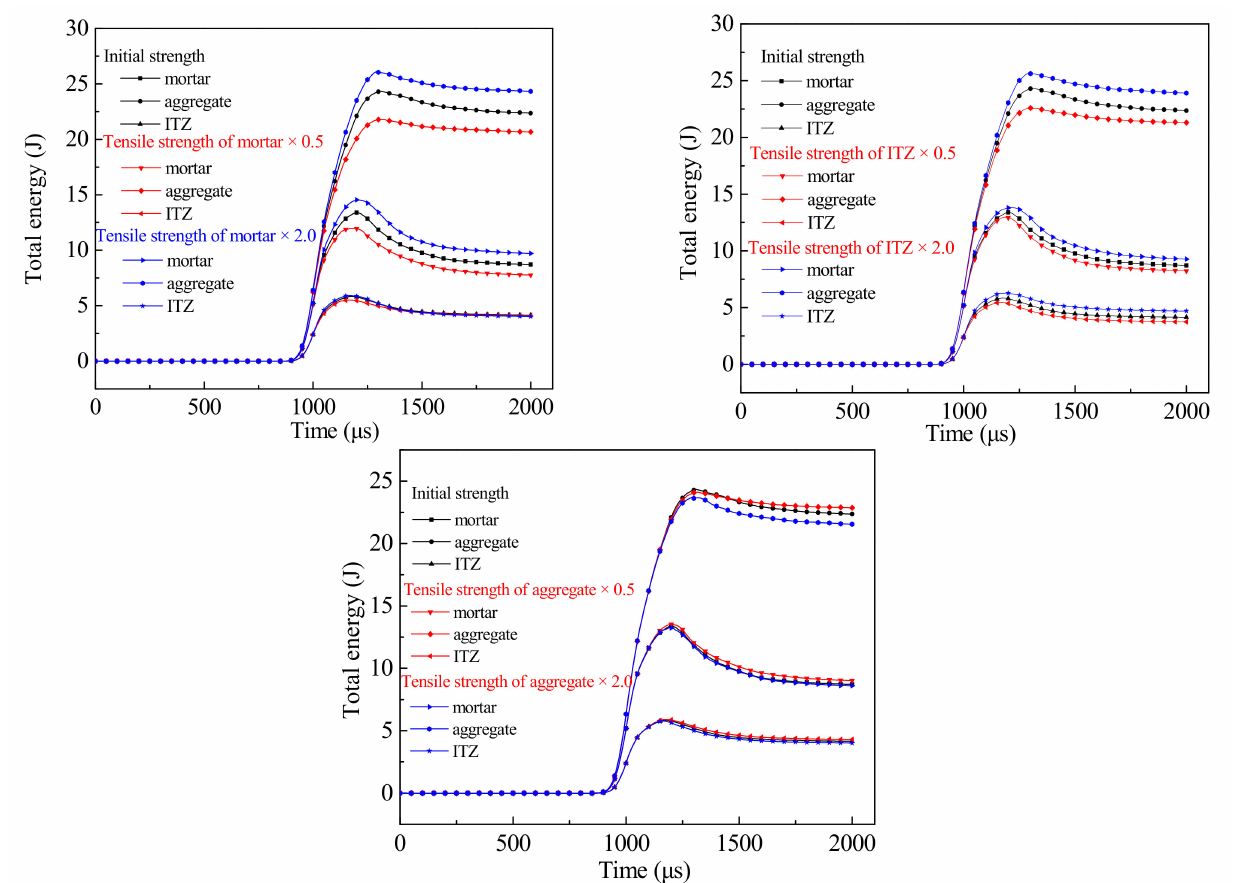
Figure 12. Energy history curves of different